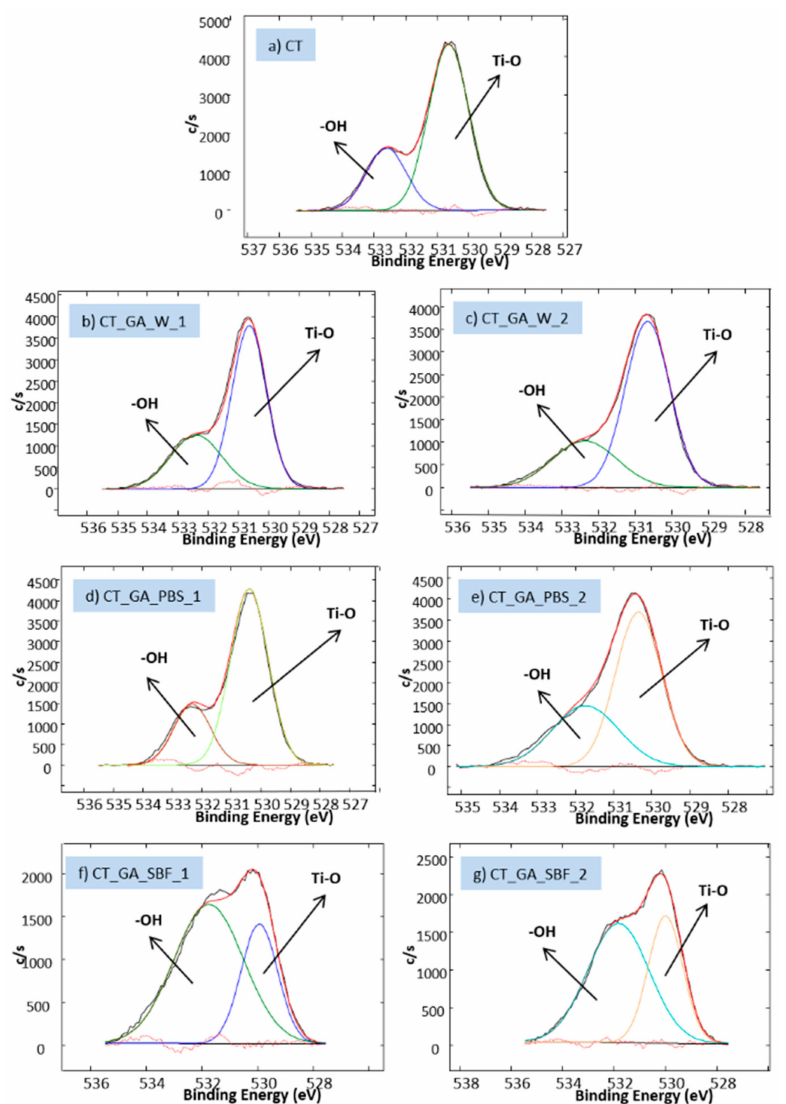
Figure 4. XPS high-resolution spectra of the oxygen region. ( a ) CT; ( b ) CT_GA_W_1; ( c ) CT_GA_W_2; ( d ) CT_GA_PBS_1; ( e ) CT_GA_PBS_2; ( f ) CT_GA_SBF_1; ( g )